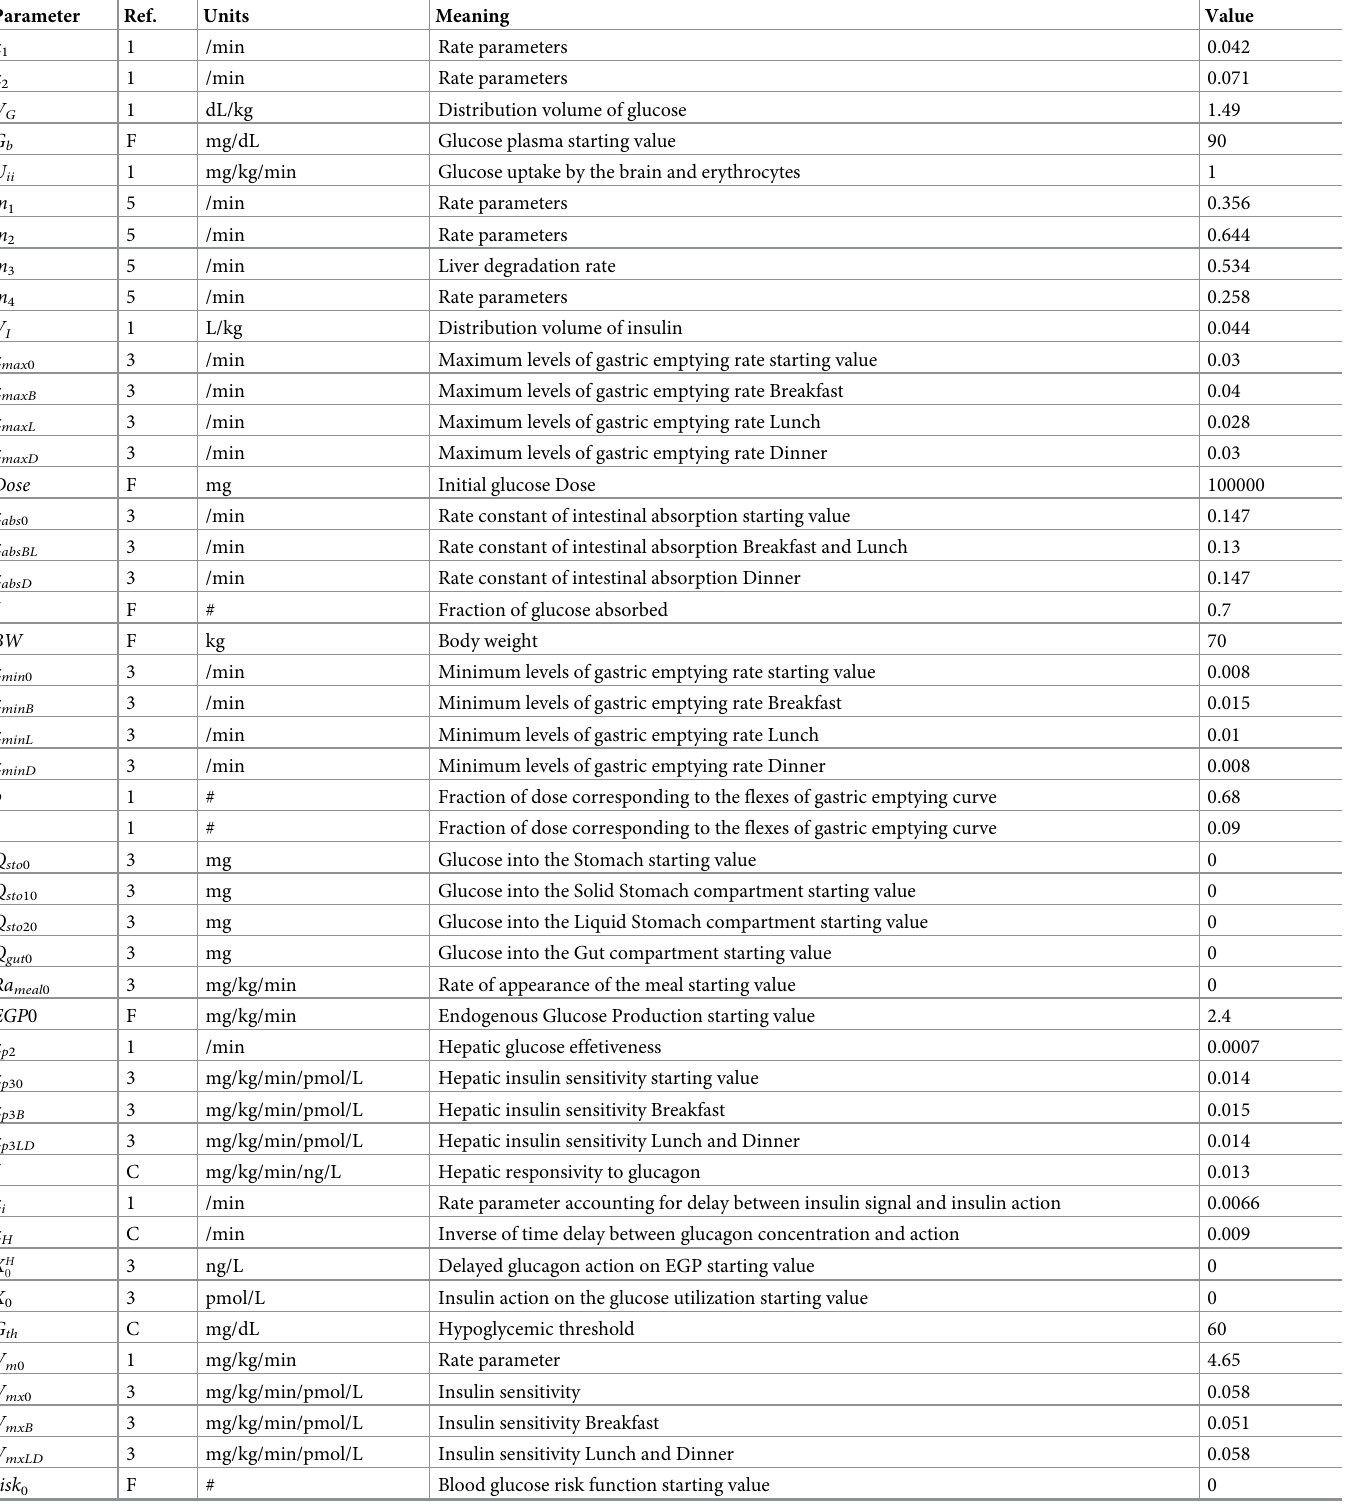
Table 4. UVAPadova model parameters. Parameter